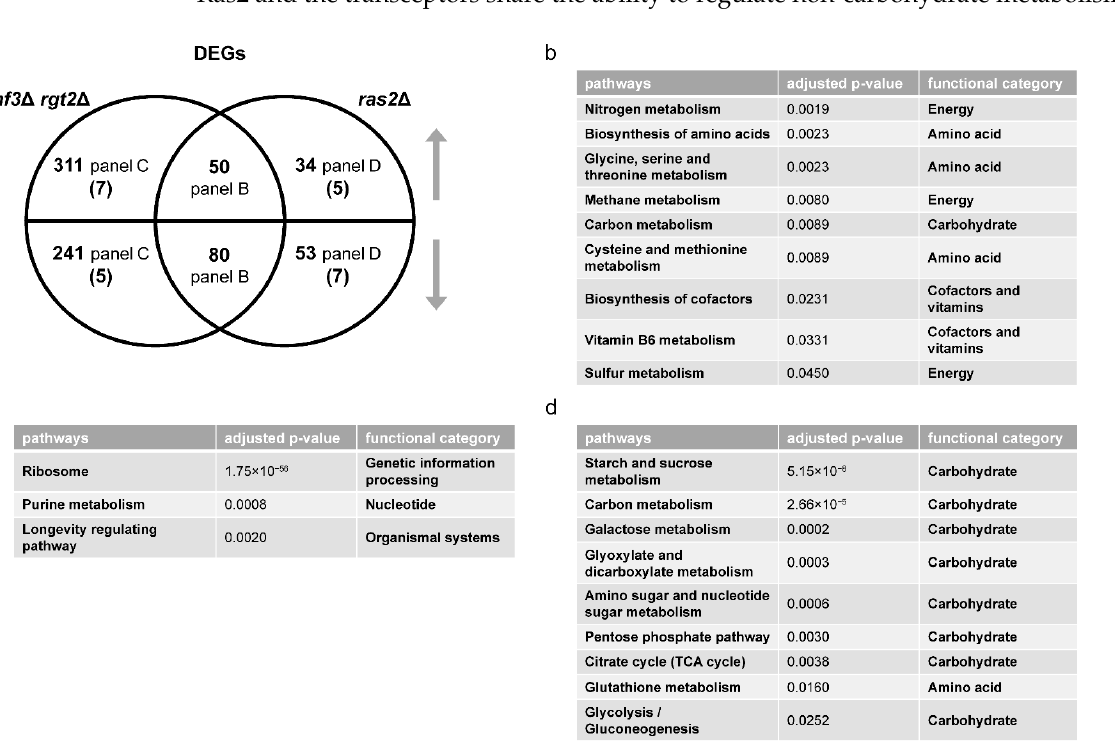
Figure 9. Comparing significantly perturbed metabolites (SPMs) of snf3 Δ rgt2 Δ and ras2 Δ . ( a ) Venn diagram of subsets of SPMs, for snf3 Δ rgt2 Δ vs. wildtype and ras2 Δ vs. wildtype, after glucose ad- dition. The upper semicircle shows up-regulated SPMs and lower semicircle shows down-regulated SPMs. Numbers in parenthesis are shared SPMs regulated in the opposite direction, and are placed in the area corresponding to the direction of regulation. SPMs used for ORA analysis that are ( b ) shared and change in the same direction; ( c )